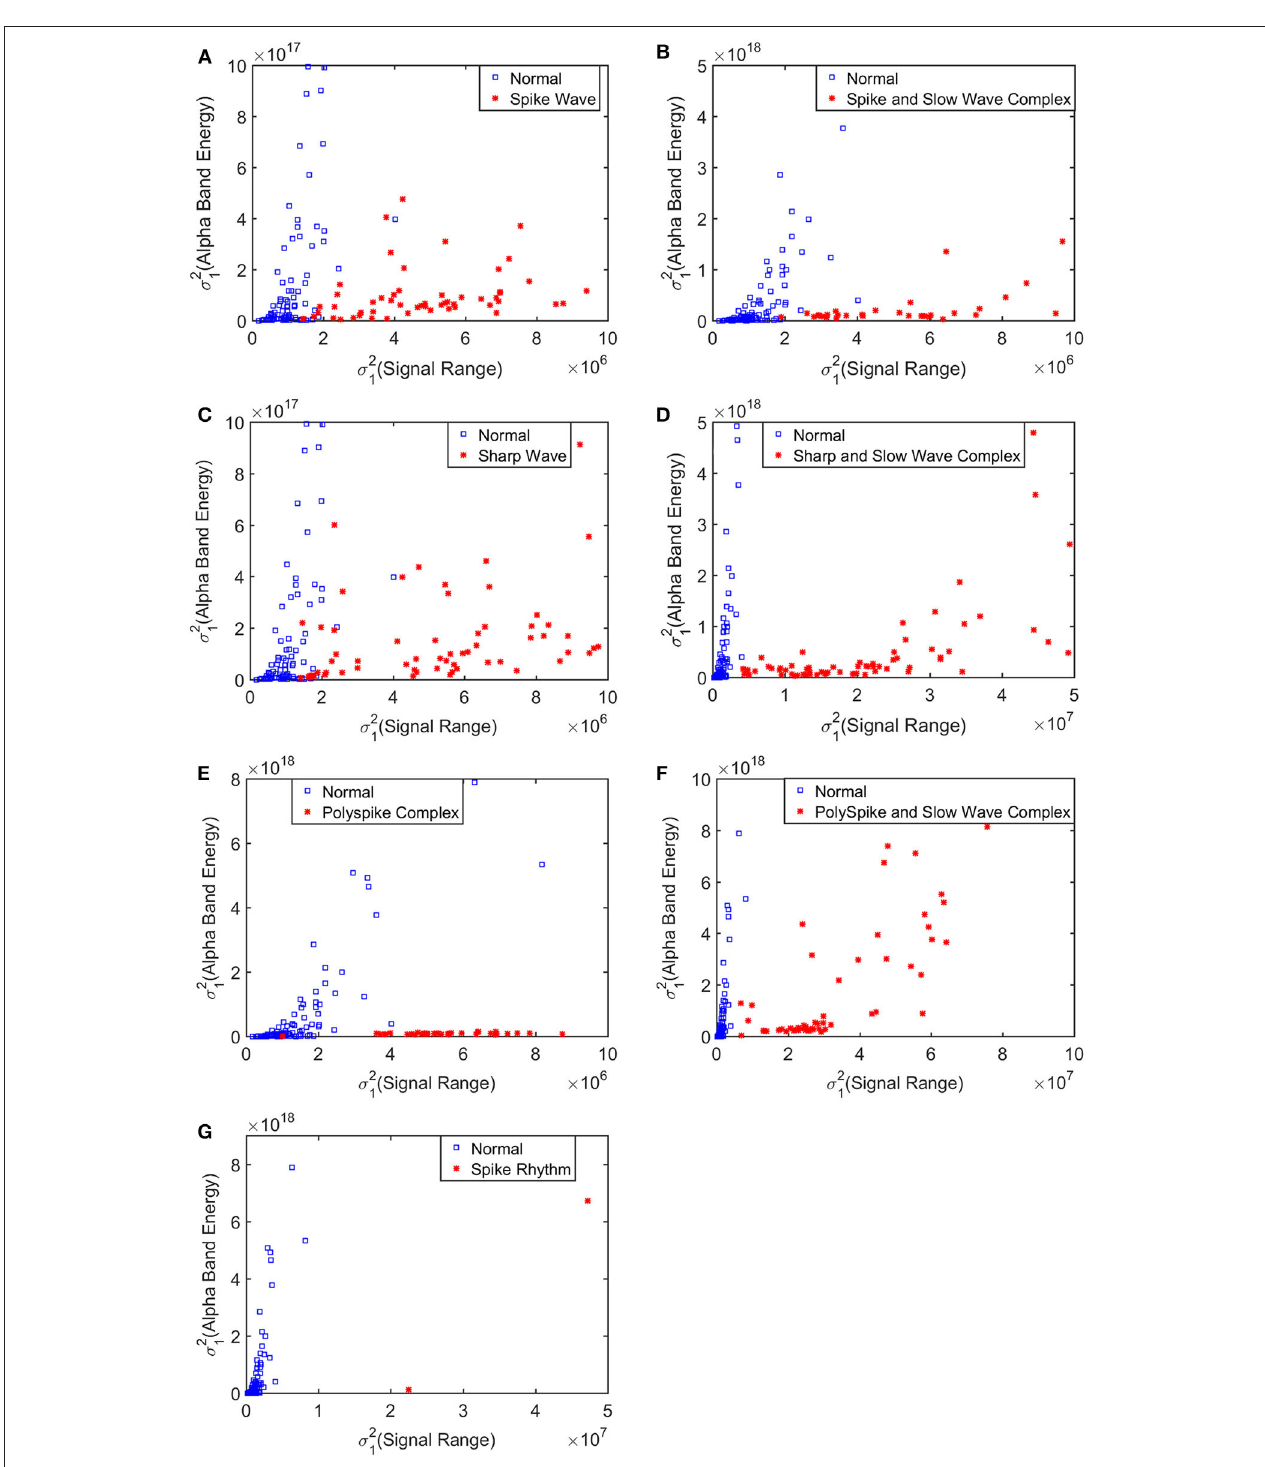
FIGURE 9 | Scatter plots using features from networks based on the Hurst parameter and the Signal Range, where (A–G) , illustrates the different between the seven types of epileptiform discharges (spike wave, spike and slow wave complex, sharp wave, sharp and slow wave complex, polyspike complex, polyspike and slow wave complex, spike rhythm discharges) and normal EEG. These plots highly suggest the classification accuracy will be very high.